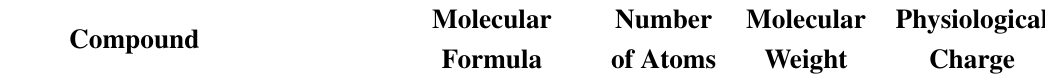
Table A1. Cont. Molecular Number Molecular Physiological Compound Formula of